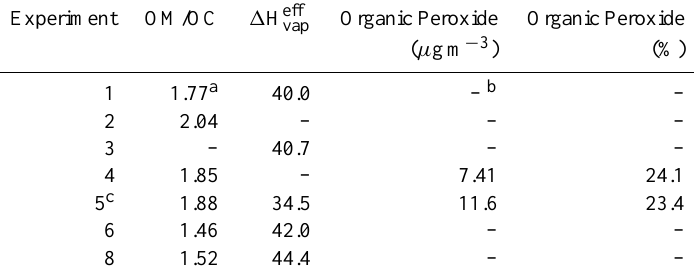
Table 4. Experimental values for the organic mass to organic carbon ratio (OM/OC), the effective enthalpy of vaporization ( 1 H eff vap ) and the total organic peroxide mass determined in the study. (Organic peroxide molar values converted to mass values assuming a molecular weight of 150gmol − 1